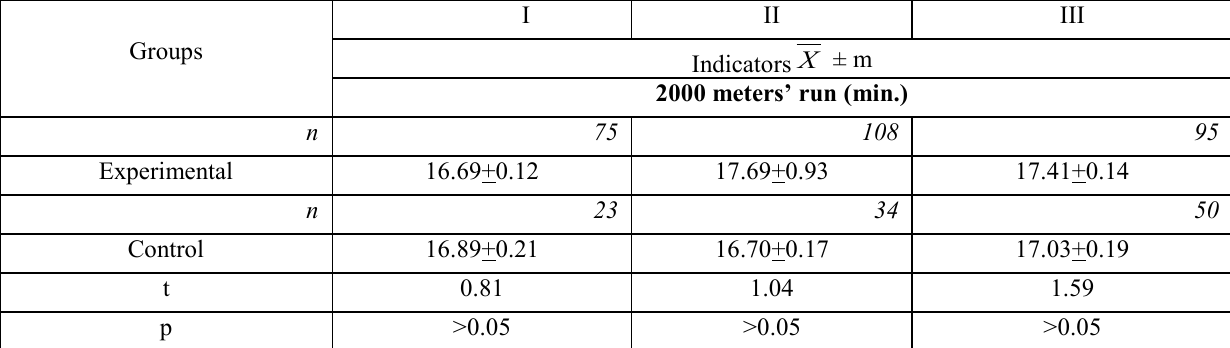
Endurance indicators of experimental and control groups’ girl students before